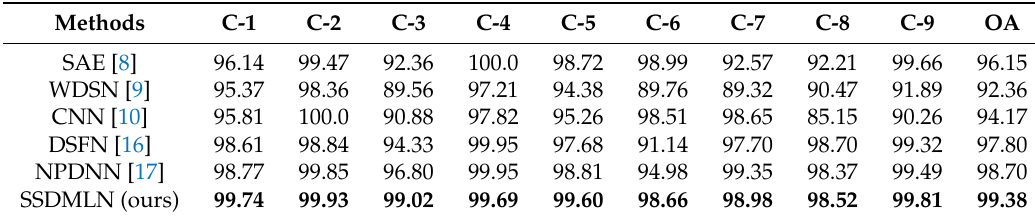
Table 1. Classification results (%) on the synthetic data set with 1% labeled data where C -1 to C -9 denote 9 different